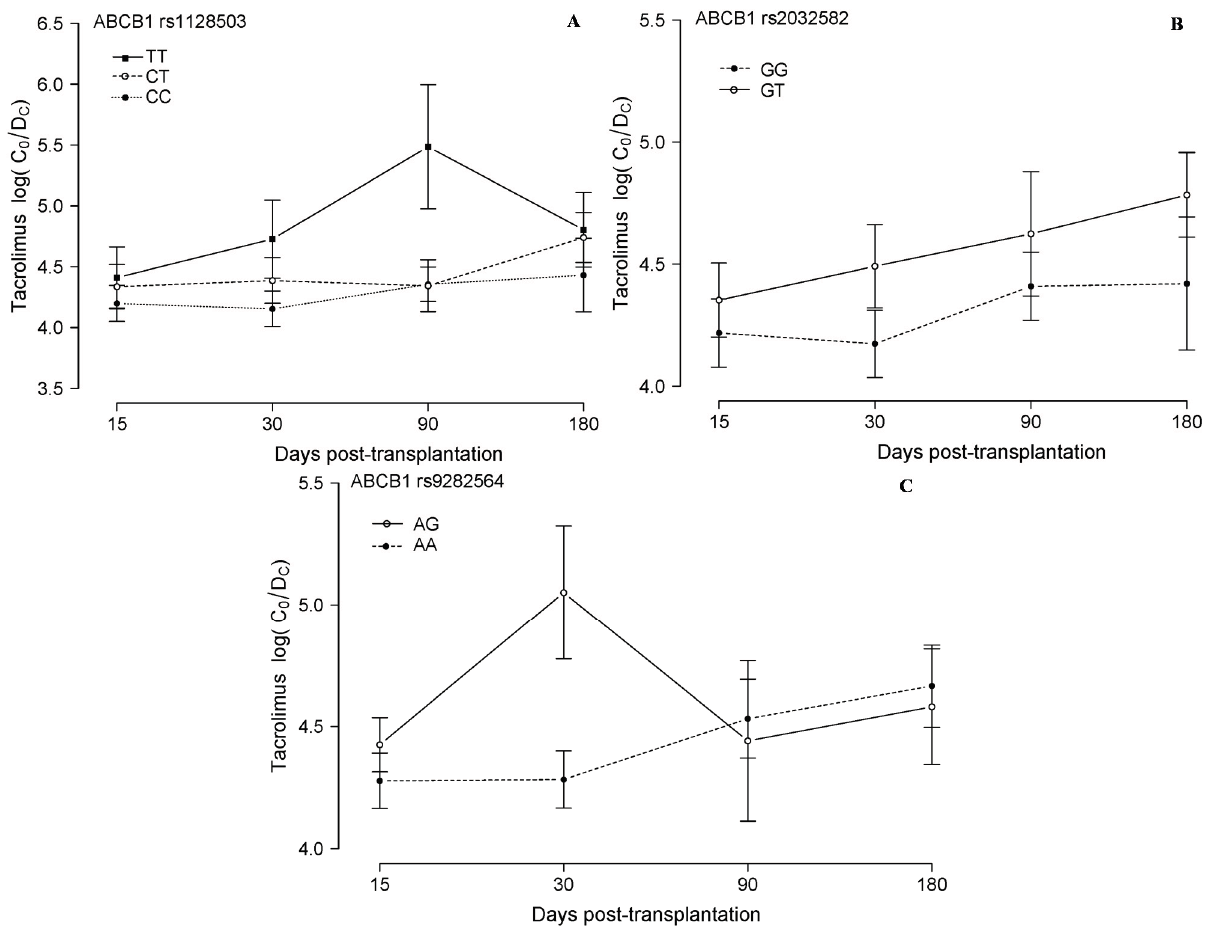
Figure 2. Tacrolimus blood concentration in relation to other ABCB1 SNPs. Tacrolimus corrected (dose/weight) trough concentrations (C 0 /D c , [(ng/mL)/(mg/kg/24 h)]) are